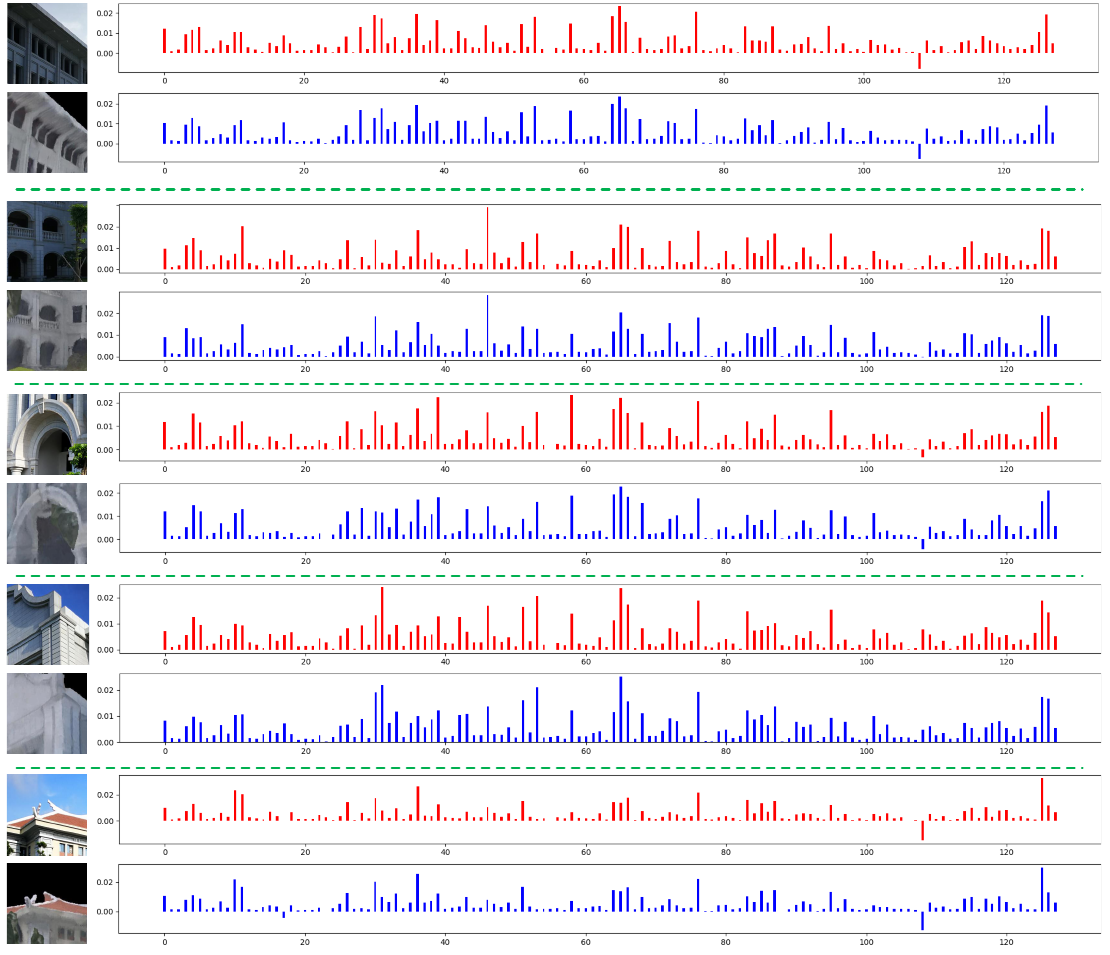
Figure 13. The histogram visualization feature descriptors learned by AE-GAN-Net on the matching patch paris of ground camera images and rendered images. For each pair of matching cross-domain image patches, the top one is ground camera image patch, the bottom one is the matching rendered image